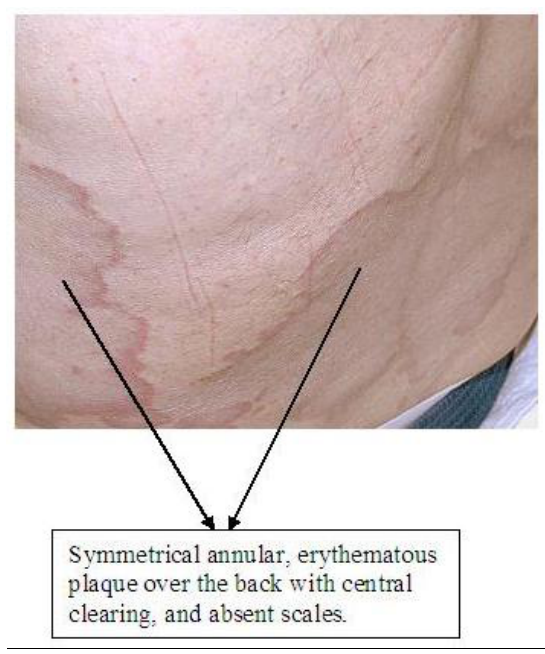
FIGURE 3. Left flank. Note the symmetrical distribution of the